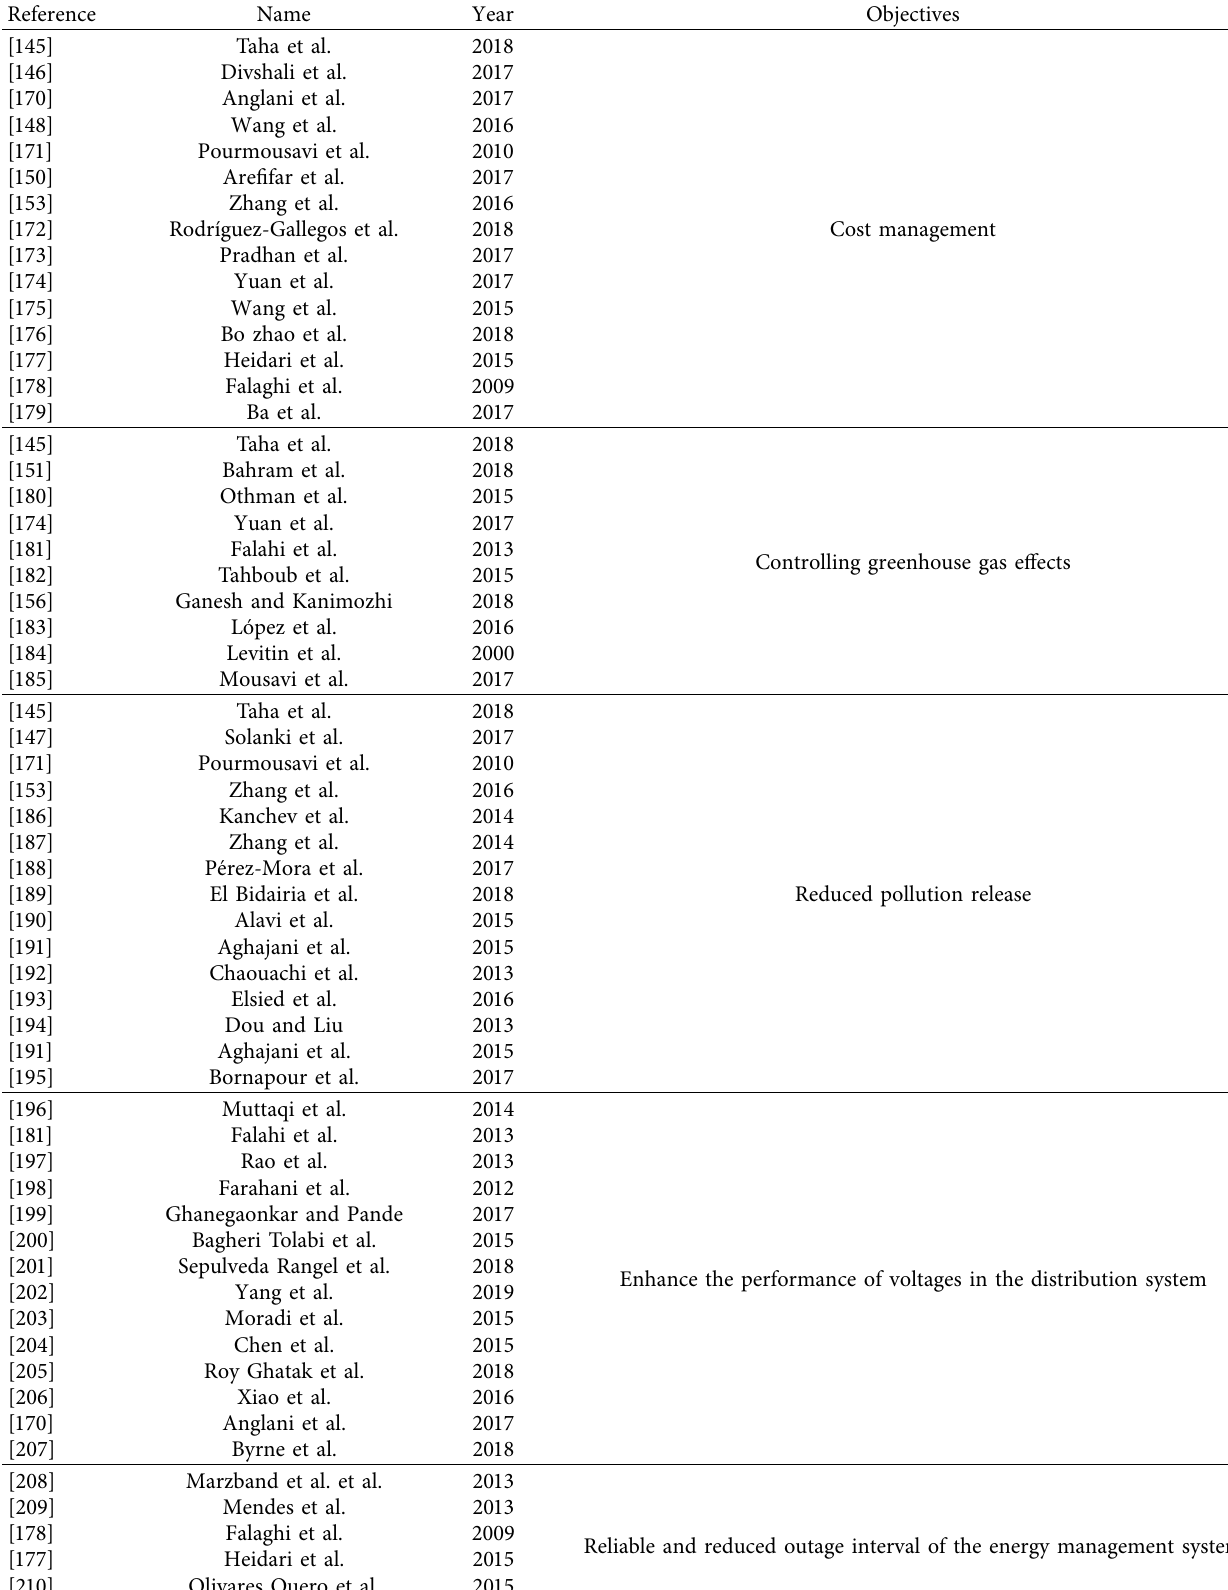
Table 7: The objective of the energy management